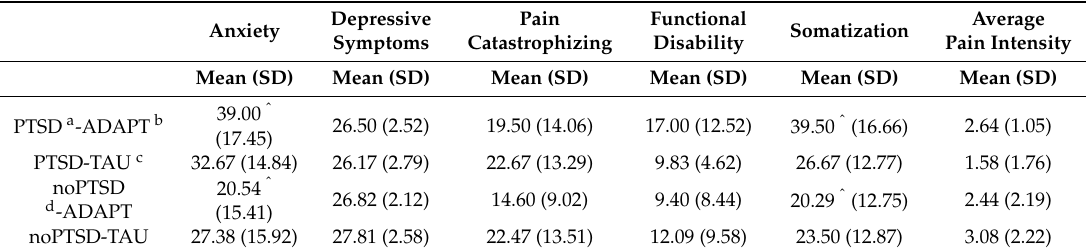
Table 3. Mean post-treatment (Time 2) outcome scores by PTSD group and intervention randomization (Aim to Decrease Anxiety and Pain Treatment (ADAPT) vs. treatment as usual (TAU)). Depressive Pain Functional Anxiety Symptoms Catastrophizing Disability